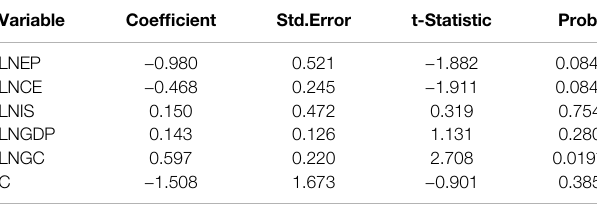
TABLE 5 | ARDL (2, 2, 2, 0, 2, 2) long-run estimates.